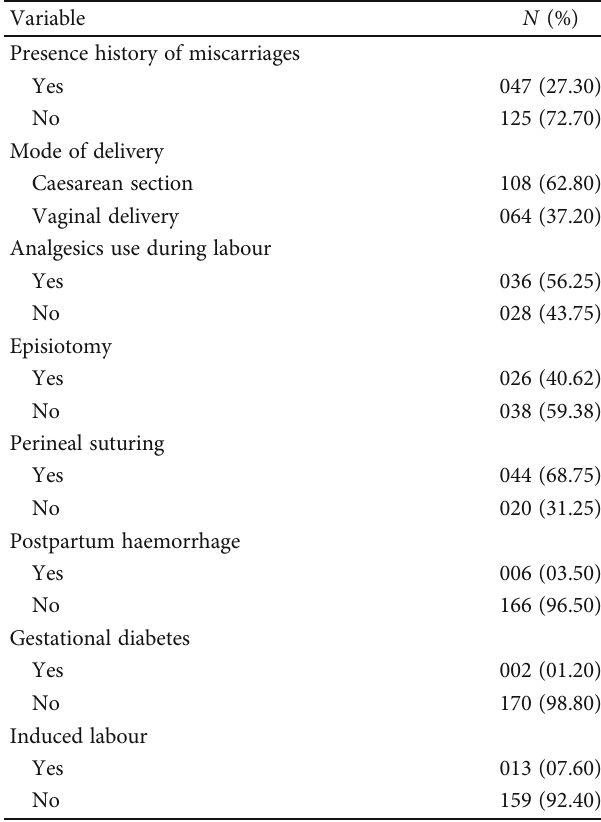
Table 1: Sample characteristics for the participants. Mean: M ; standard deviation: SD; %: percent ( N = 172